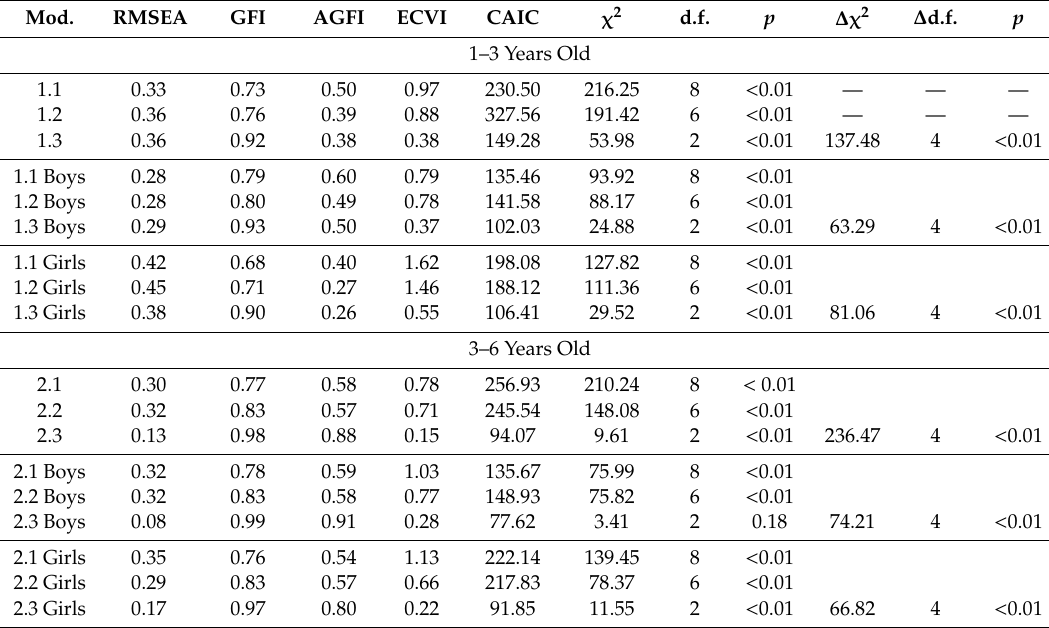
Table 5. Fit indices of the